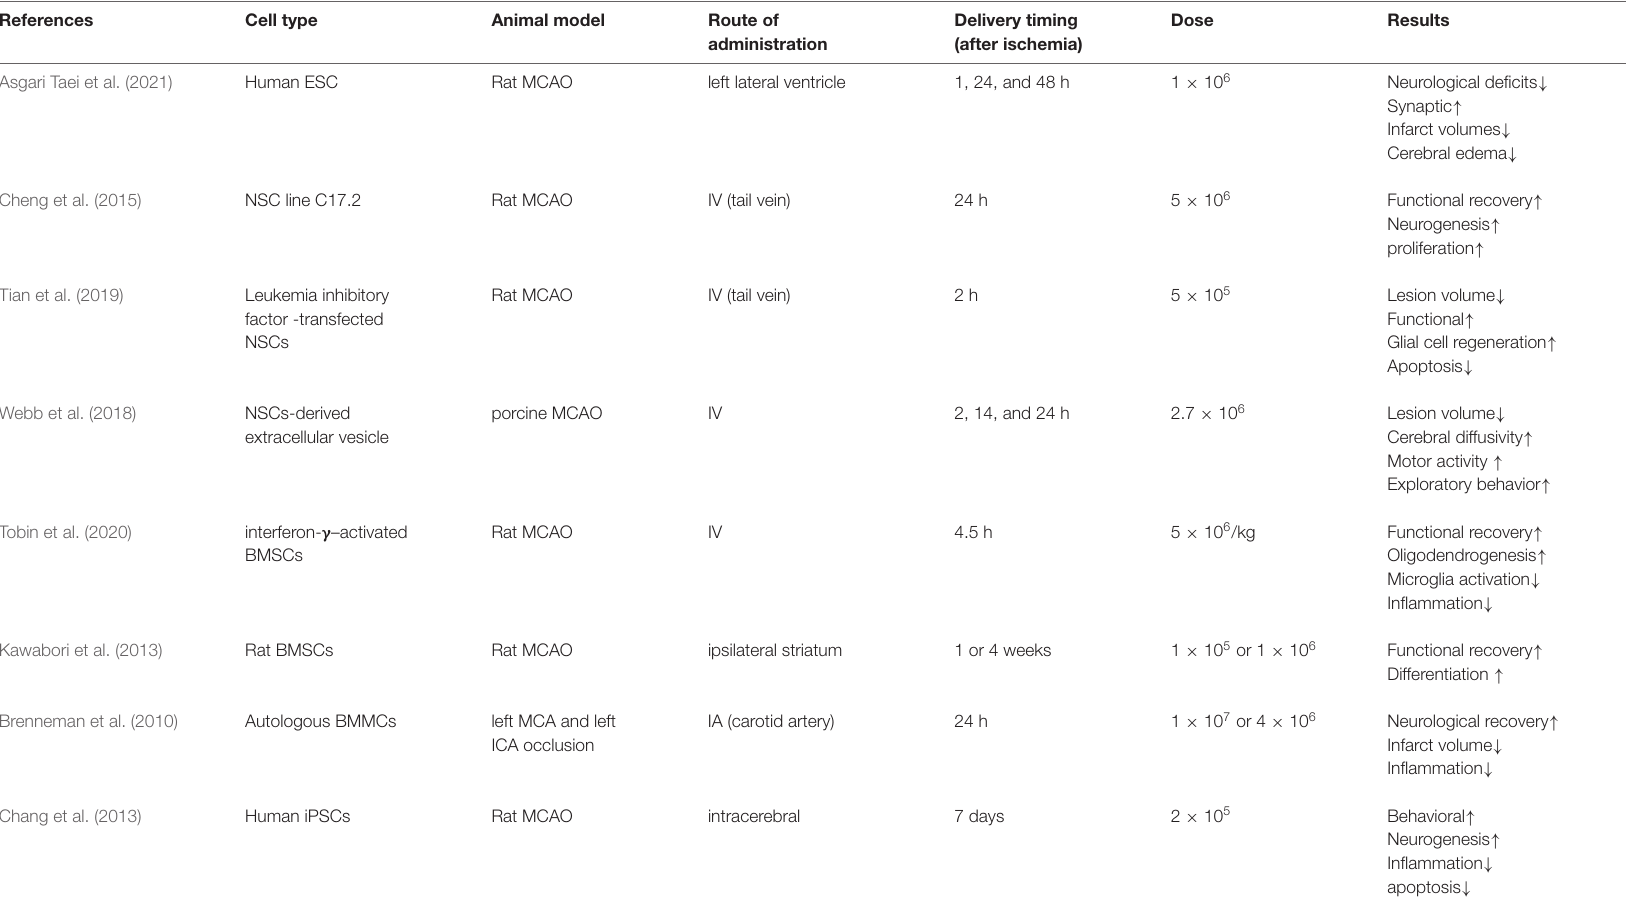
TABLE 1 | Experimental study for various stem cells transplantation into the ischemic